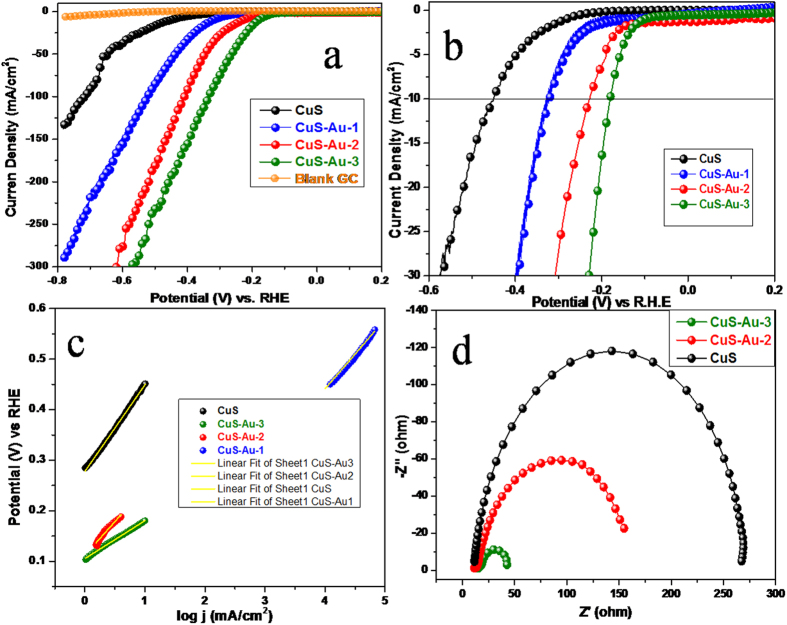
(a,b) Polarization curves for bare GC, CuS, CuS-Au-1, CuS-Au-2 and CuS-Au-3 in 0.5 M H2SO4. (c) Tafel plots of CuS, CuS-Au-1, CuS-Au-2, and CuS-Au-3, (d) Nyquist plot of CuS, CuS-Au-2 and CuS-Au-3.